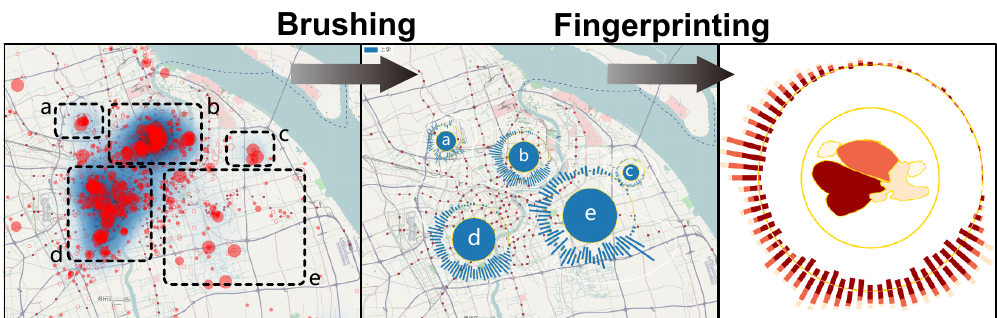
Figure 6. User-controlled Region Partitioning and Fingerprinting. This feature allows users to draw the interested area in any geometric shape and Sci-Fin can handle it as the geometric region input instead of the administration regions constructed by the government. Then Sci-Fin can return the results in real